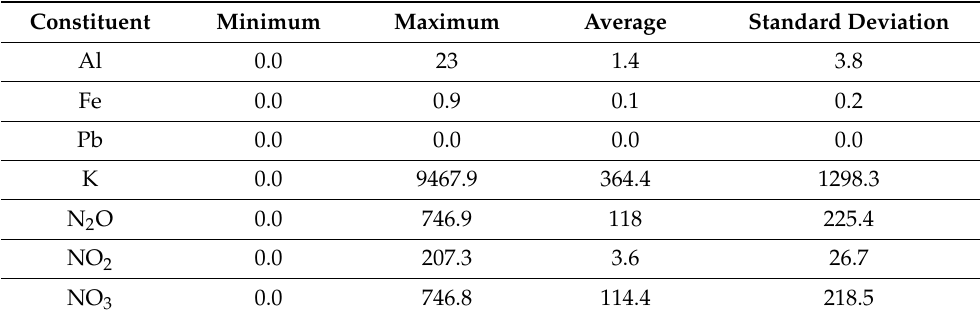
Table 2. Data parameters for undigested aerosol dust results (soluble fractions) in rainfall using the Colorimetric Nutrient Analyzer and ICP-MS analysis. All values are in µ g/L.